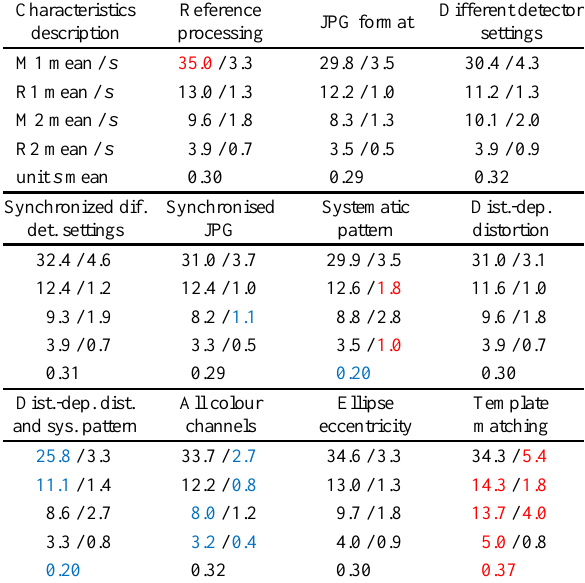
Table 2. Quality characteristics [µm]. Overview. M1 –